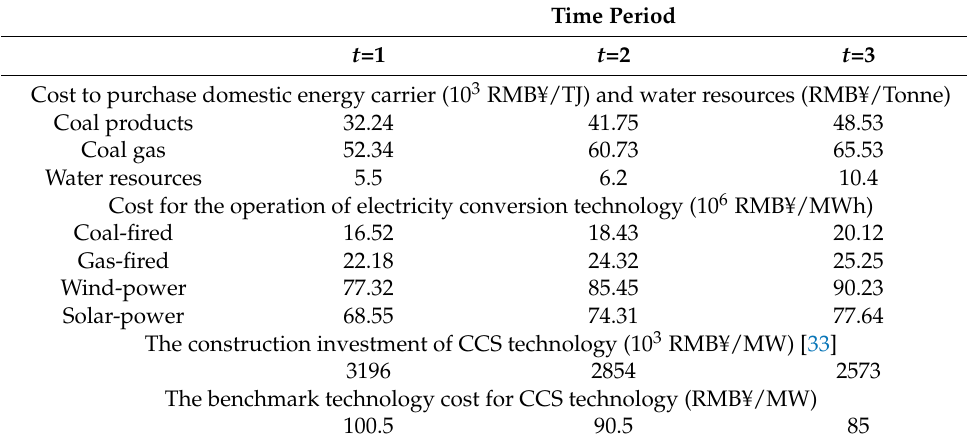
Table 4. Economic and technological data for different power